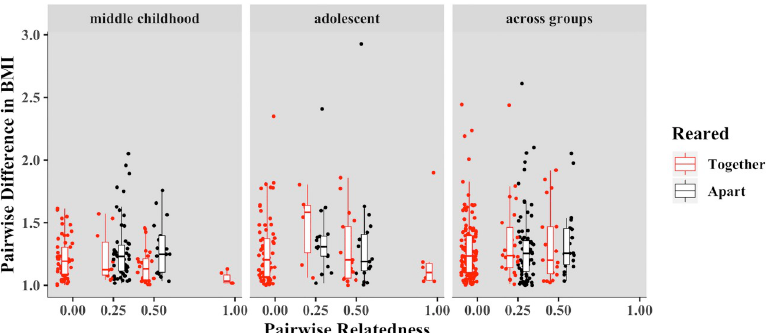
Fig 1. Pairwise difference in BMI by age group. Boxplots depicting the distribution of observed values of pairwise differences in BMI among pairs of varying relatedness and home sharing status within each age group. Each point is a pairwise difference in BMI for a given pair of children in the dataset. In general, differences in BMI were smaller in related children in the middle childhood group, and in those sharing a home environment.